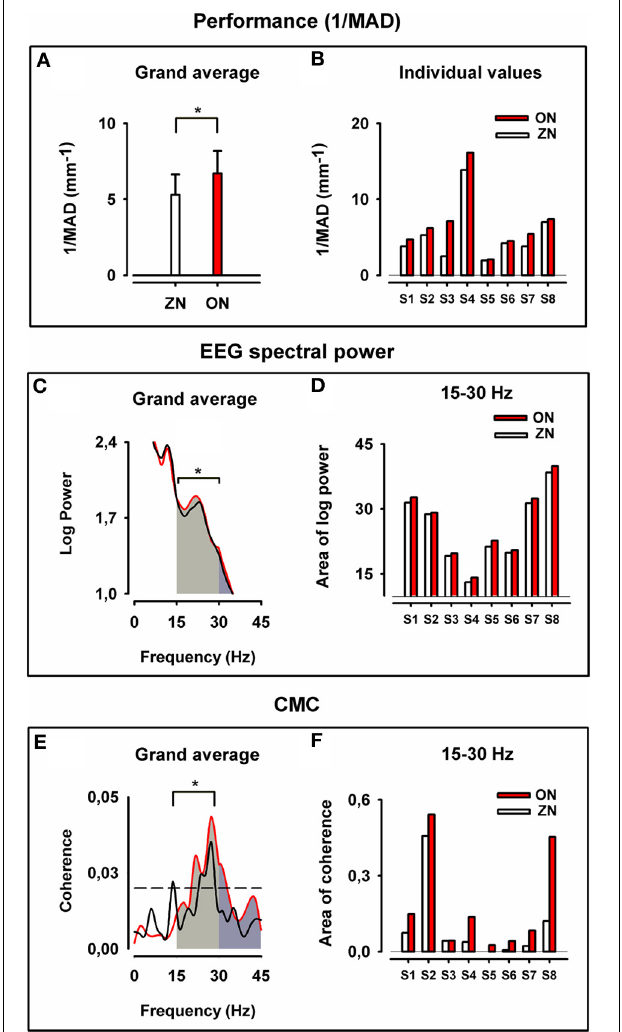
FIGURE 2 | Motor performance, cortical motor spectral power and corticomuscular coherence for zero noise (ZN, black) and optimum noise (ON, red). Upper panel: Grand average of the inverse of the mean absolute deviation (1/MAD) of the finger position in (A) and individual values of (1/MAD) in (B) . Note the stochastic resonance (SR) effect with better performance for ON ( ∗ p = 0 . 008). Middle panel: Grand average for cortical motor log SP in (C) for ZN and ON and plots of the individual values of area under the curve of log SP for both conditions in beta range (D) . Note the stronger cortical motor log power for beta-range ( ∗ p = 0 . 008). Lower panel: Grand average of CMC in (E) and individual plots for all values (areas under the curve and above the significance level) in beta range (F) . Note the higher CMC for ON in beta-range ( ∗ p = 0 . 008). In (E,F) for ZN and ON data from the same muscle were taken for the